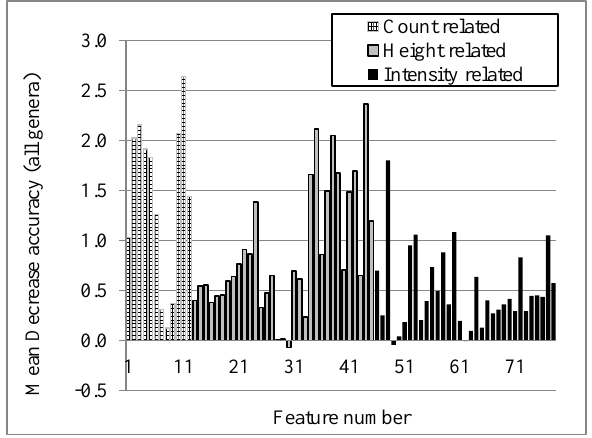
Figure 4. The mean decrease permutation accuracy for all genera for vertical profile derived